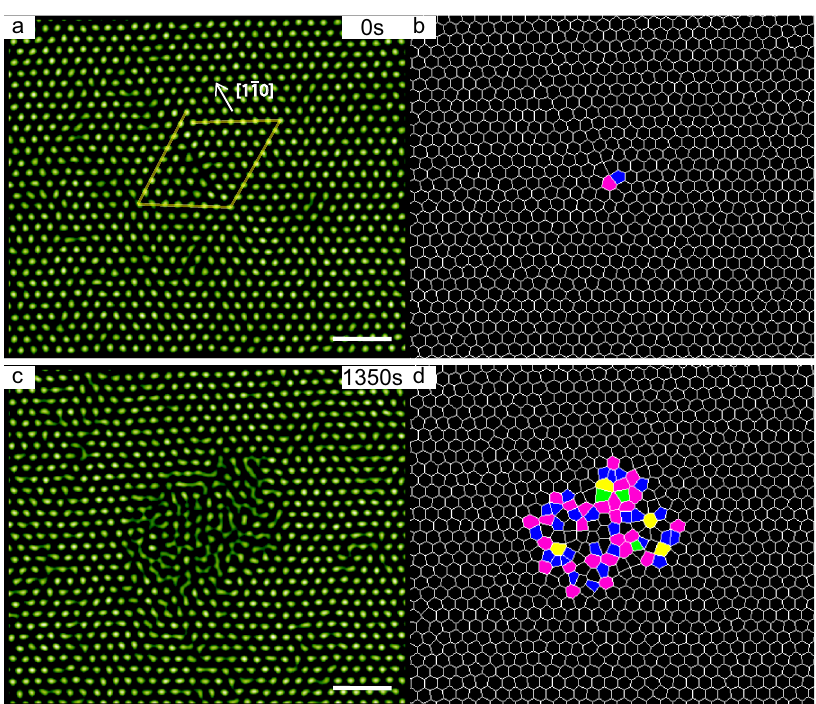
Fig. 4 Nucleation on a single dislocation. a and c are real images, b and d are the corresponding Voronoi diagrams for better visualisation. c and d show the state 1350 s after turning on the heating light. The degree of superheating Δ T = 1.0 °C (i.e., Δ ϕ = 0.059). Voronoi cells are coloured according to the number of the nearest neighbours: 4-green; 5-blue; 6-black; 7-magenta; 8-yellow. The Burgers circuit in a reveals a full dislocation with the Burgers vector ½ 110 (cid:3) = 2 of the lattice constant, which is featured as a 5 – 7 pair in the Voronoi cells. The nucleation has just started on the object plane. Scale bars: 5 μ